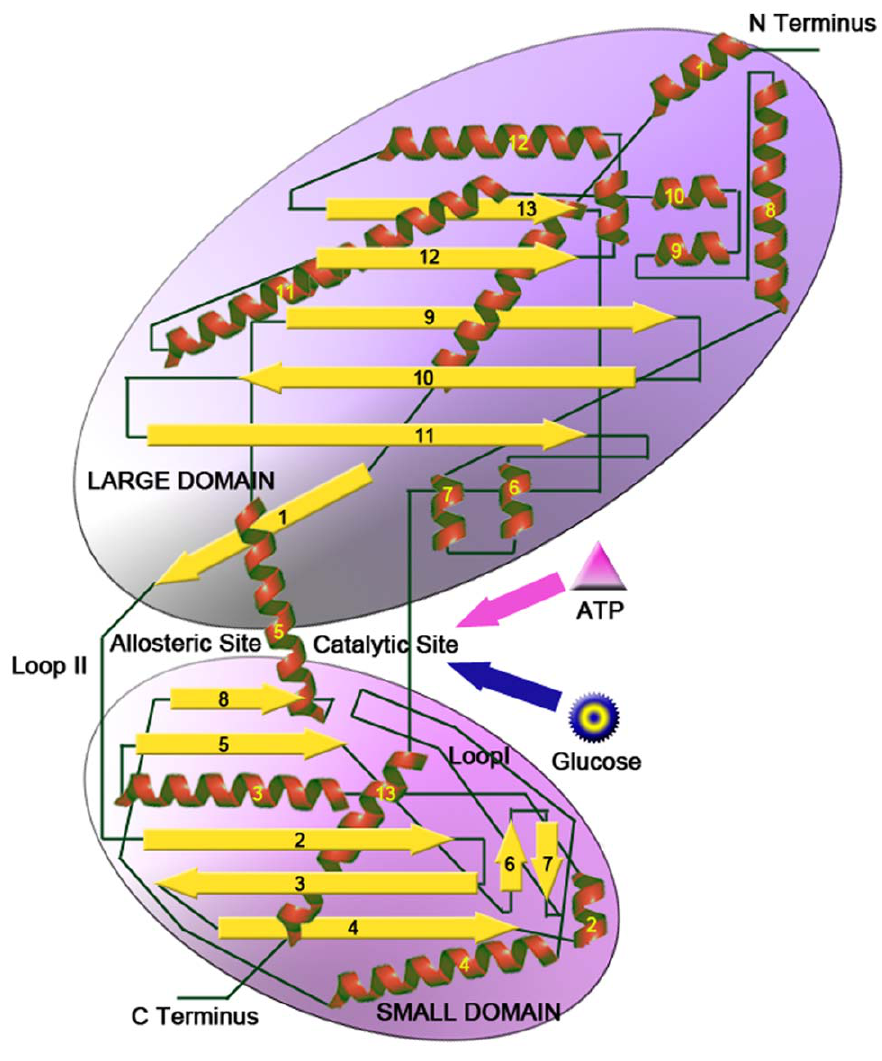
Figure 1. 2D topological structure plot of GK.